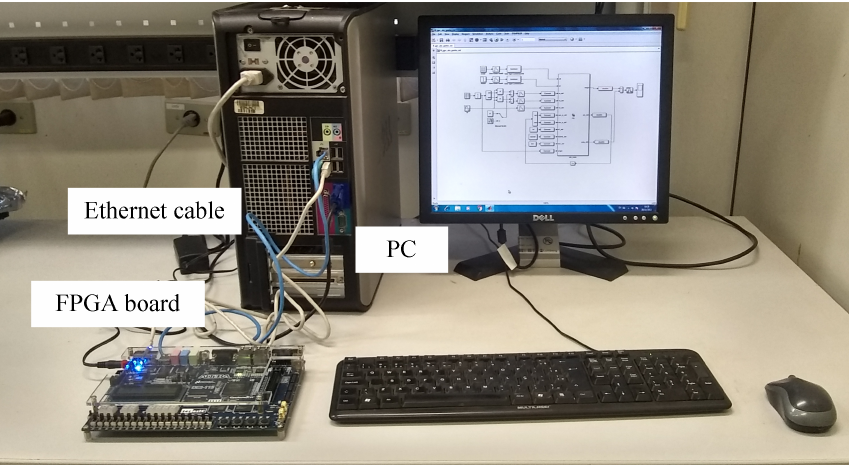
Figure 14. Experimental